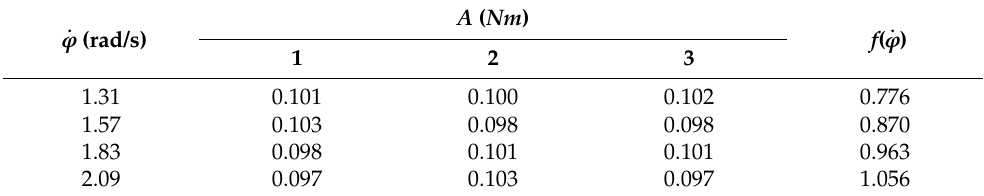
Table 1. Fitting parameters of dynamic friction